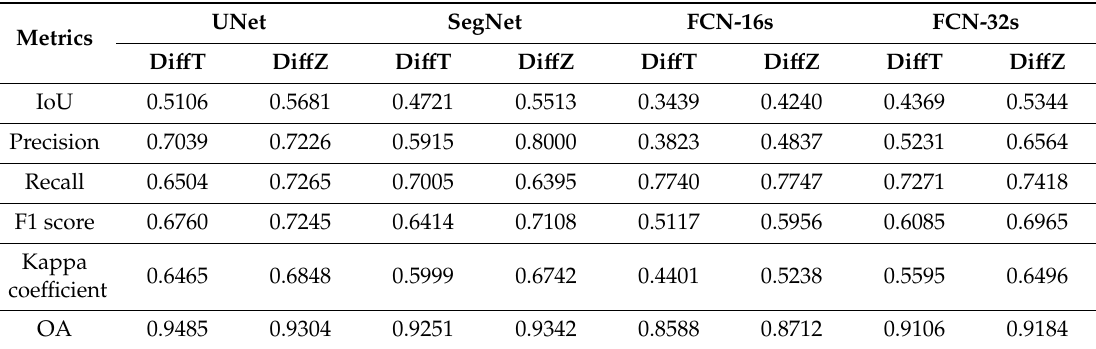
Table 7. Evaluation results on two test